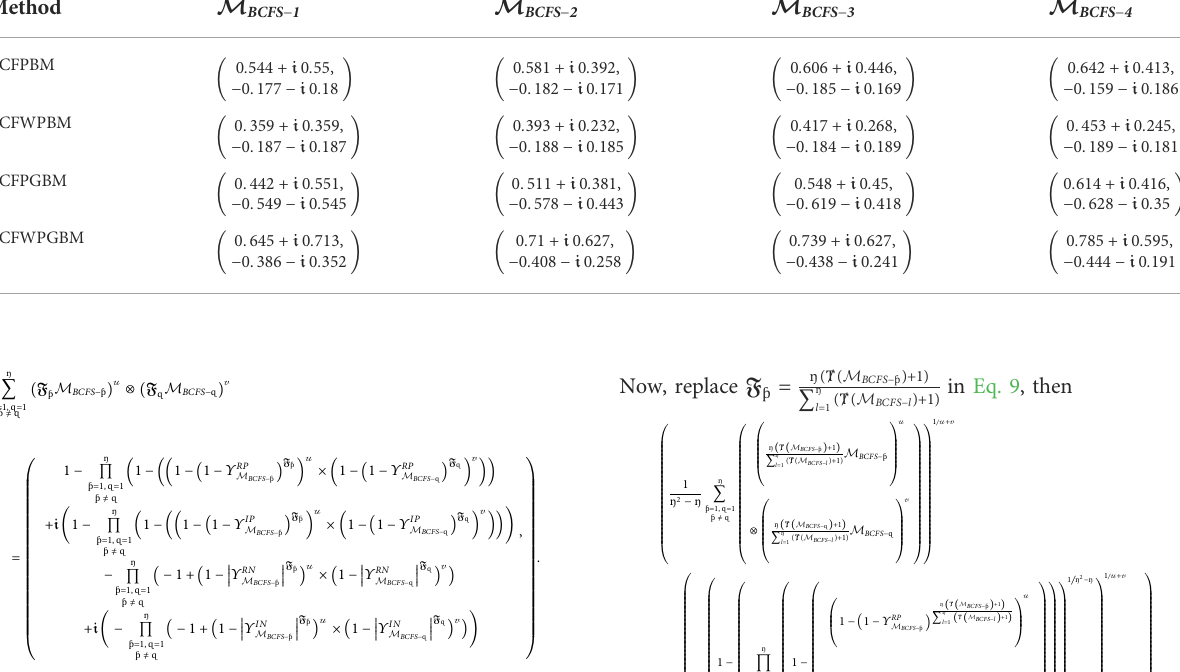
TABLE 2 Aggregated values of information are described in Table 1. Method M BCFS −